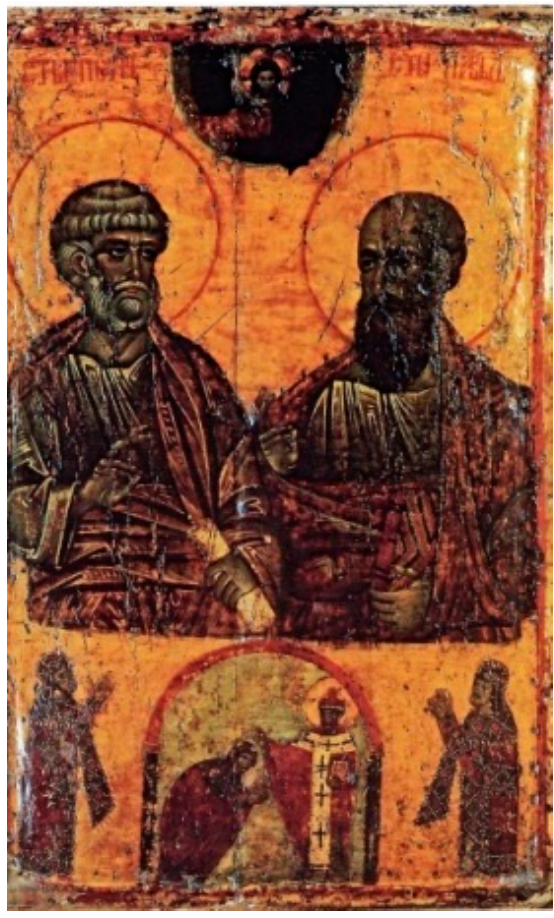
Figure 9. Queen Helen as a nun flanked by her sons, Dragutin and Milutin, Sts. Peter and Paul icon around 1282, 74 × 49 cm. (copyist: Z. Živkovi ć ). The Gallery of Frescoes, Belgrade. Inv. No. 870. Photo courtesy of The Gallery of Frescoes, Belgrade.